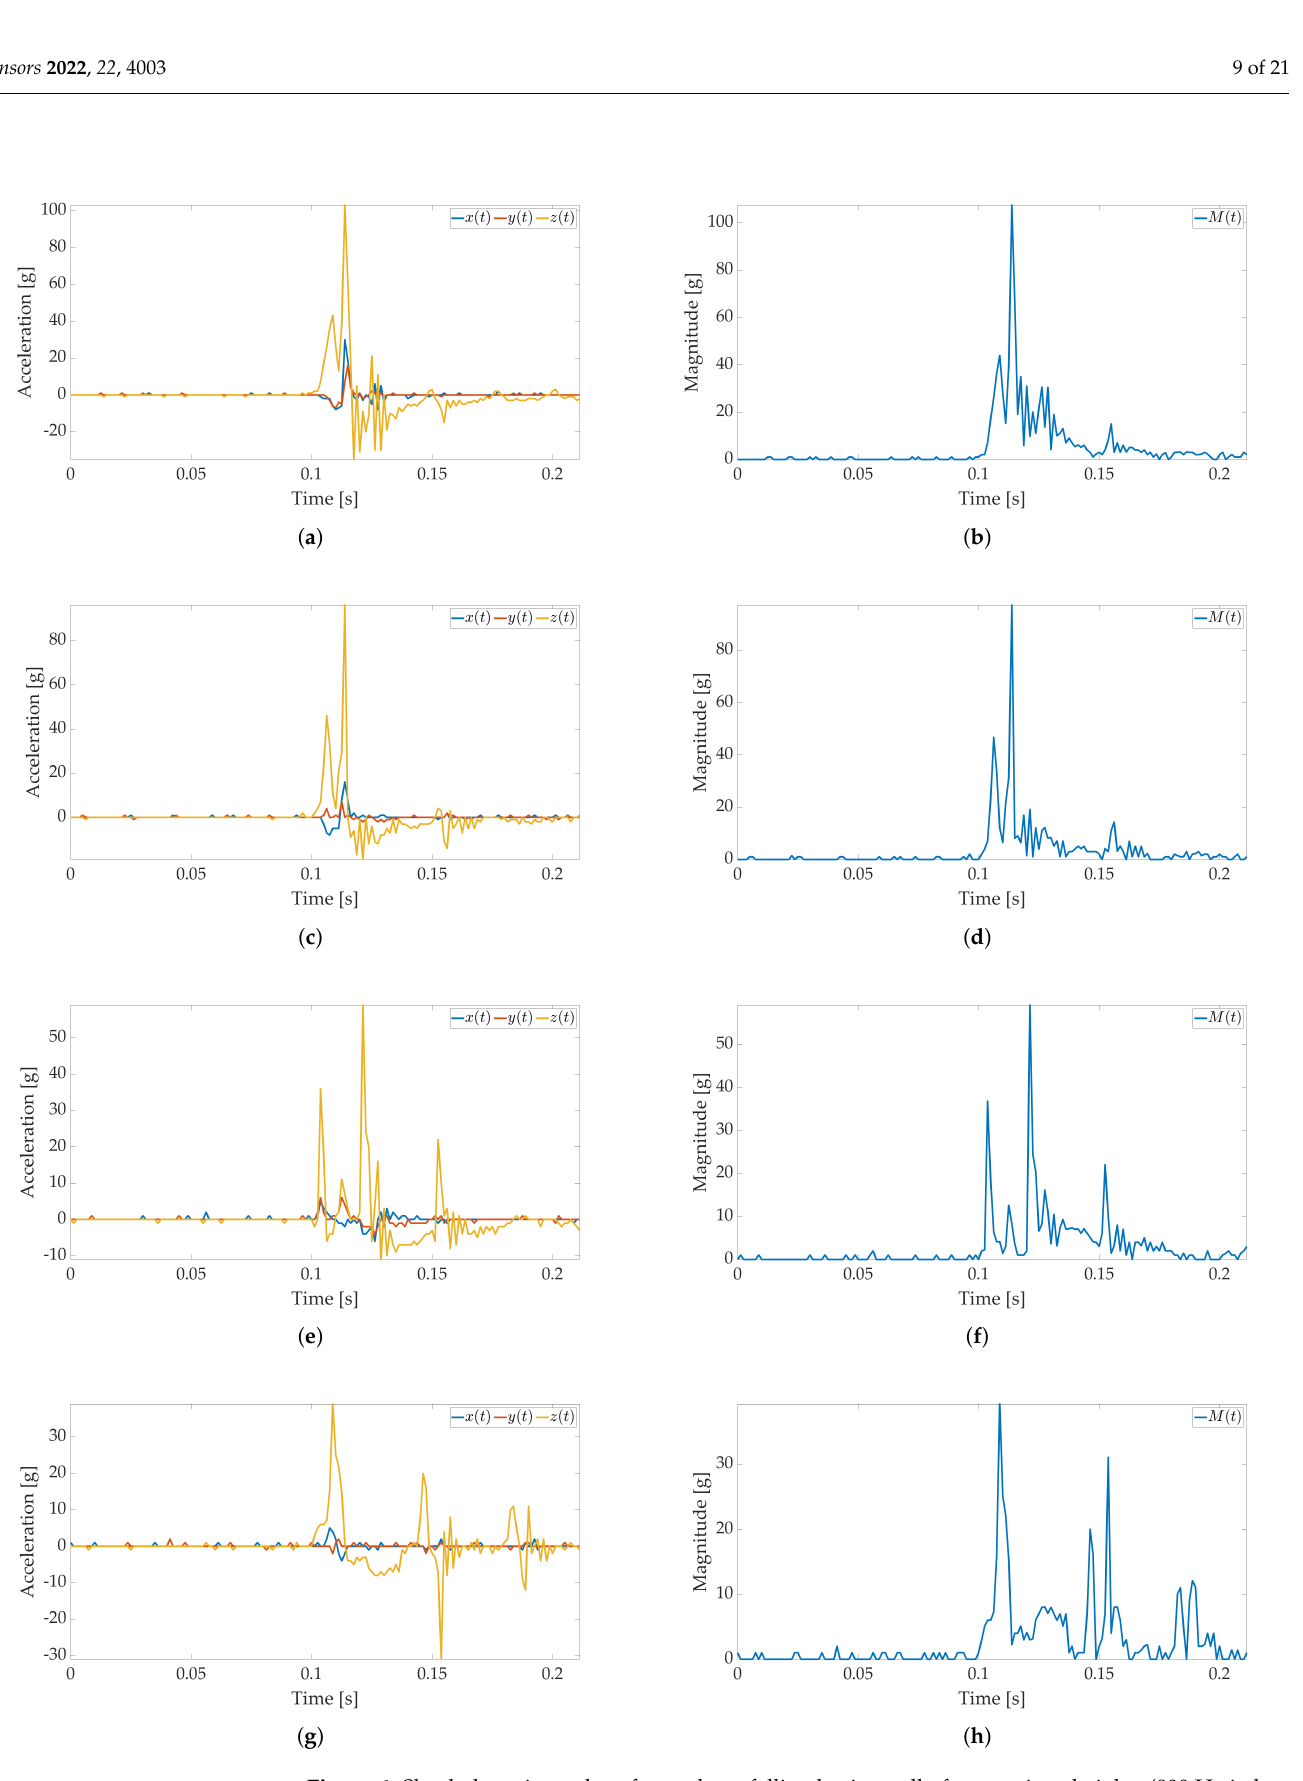
Figure 6. Shock detection values for package falling horizontally from various heights (800 Hz in box without FIFO). Acceleration axes on figures ( a ) (100 cm), ( c ) (50 cm), ( e ) (20 cm), ( g ) (10 cm) and acceleration magnitude waveform on figures ( b ) (100 cm), ( d ) (50 cm), ( f ) (20 cm), ( h ) (10